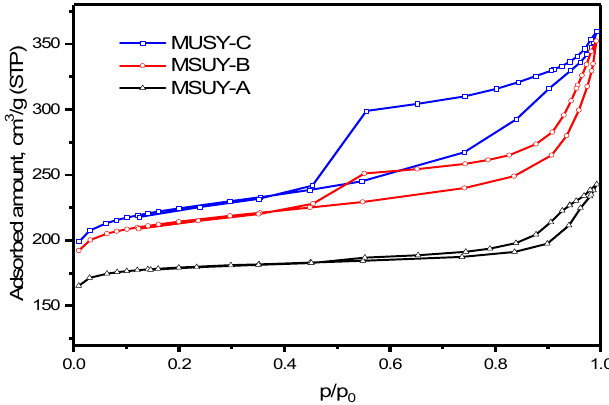
Figure 1. N 2 adsorption–desorption isotherms of the zeolites.